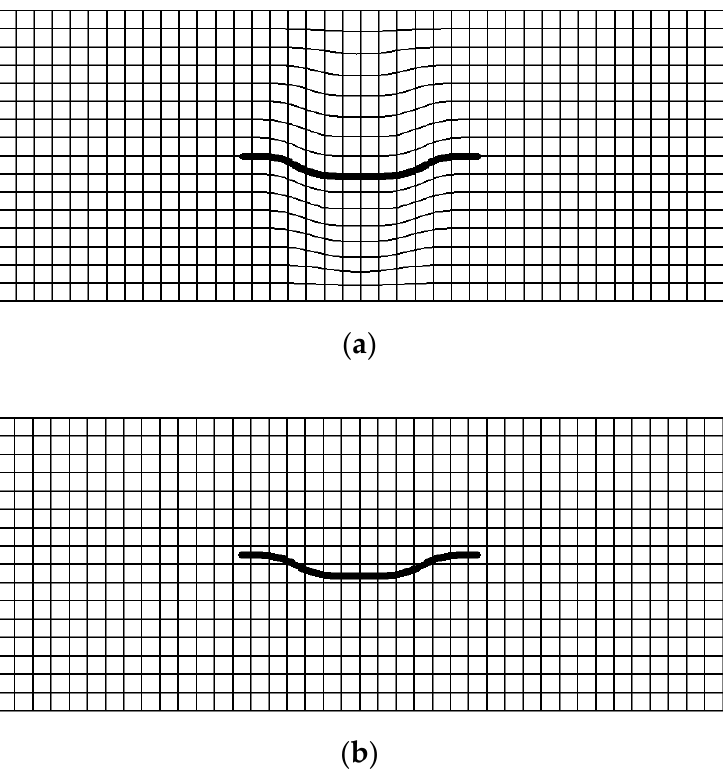
Figure 10. ( a ) Lagrangian treatment of the moving boundary; ( b ) Eulerian treatment of the moving